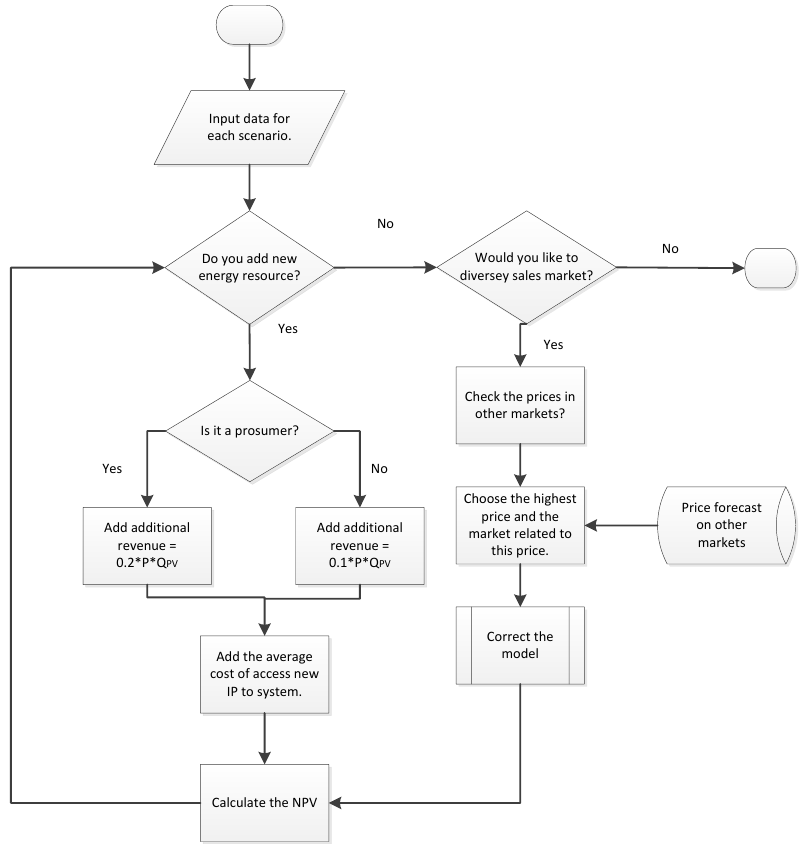
Figure 3. Efficiency-estimation model. Figure 3. E ffi ciency-estimation